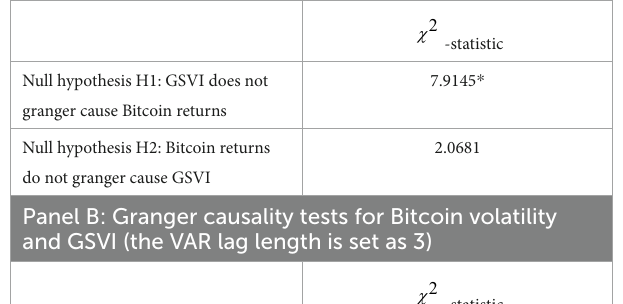
TABLE 3 Results for the Granger causality tests and the corresponding VAR estimations. Panel A: Granger causality tests for Bitcoin returns and GSVI (The VAR lag length is set as